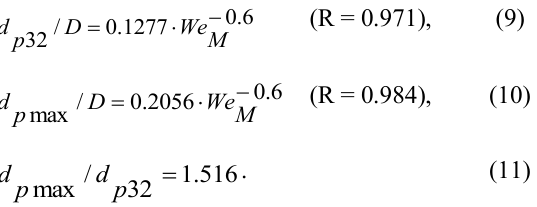
Fig. 8. Dimensionless correlations for ratios d p32 /D and d pmax /D – Rushton turbine.